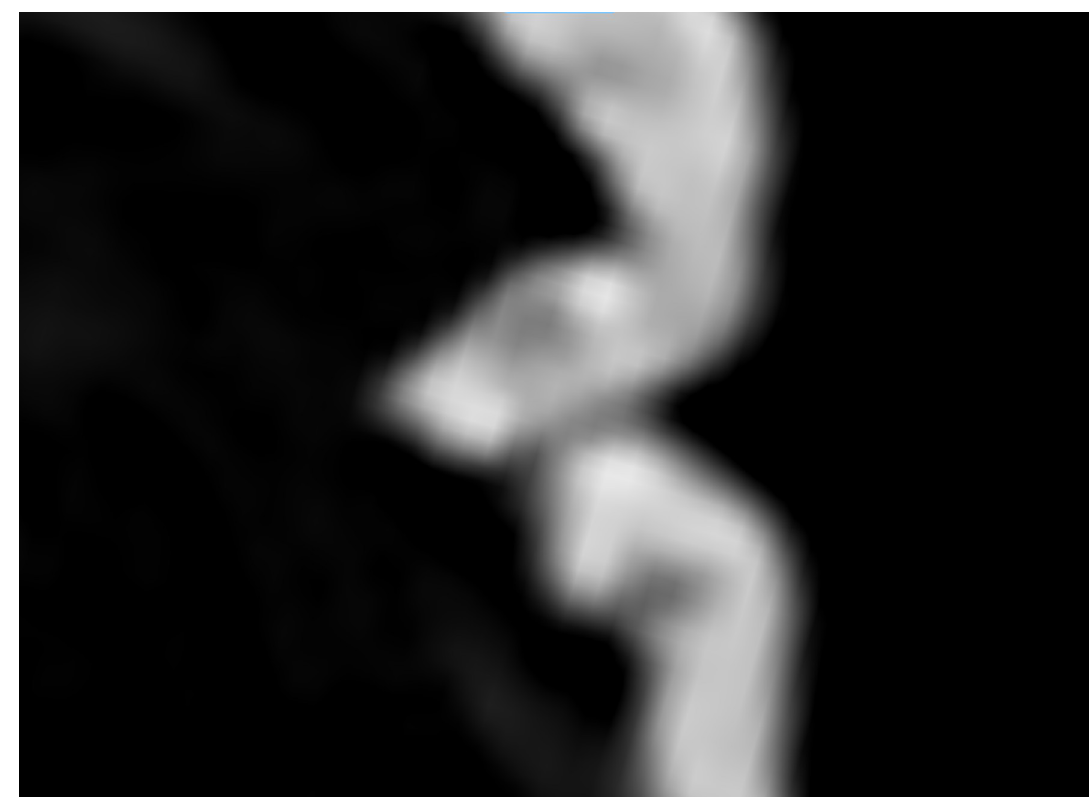
Fig 4. Comparative slice images of the eye at different resolutions. Clinical CT coronal slice through the eye.